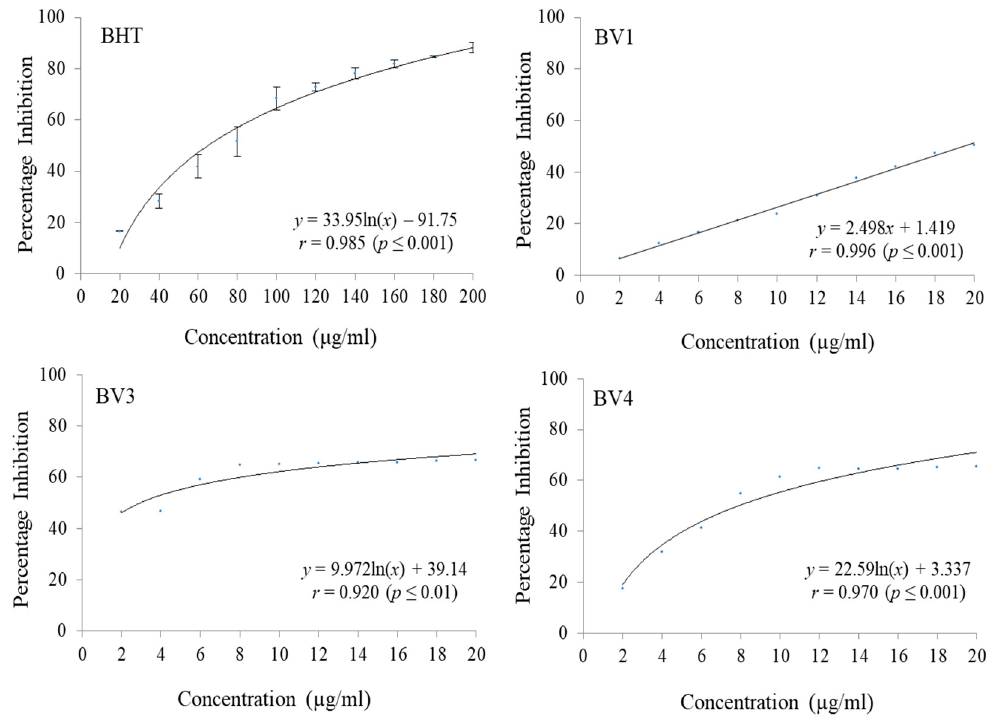
Figure 5. The DPPH radical scavenging activities of standard reference compound BHT and compounds isolated from Bauhinia variegata L. stem bark. BHT = butylated hydroxytoluene (standard reference compound); BV1 = kaempferol; BV3 = protocatechuic acid methyl ester; BV4 = protocatechuic acid. Table 6. IC 50 , one-way ANOVA F-ratio and HSD values of BHT and compounds isolated from Bauhinia variegata L. stem bark in DPPH radical scavenging assay.